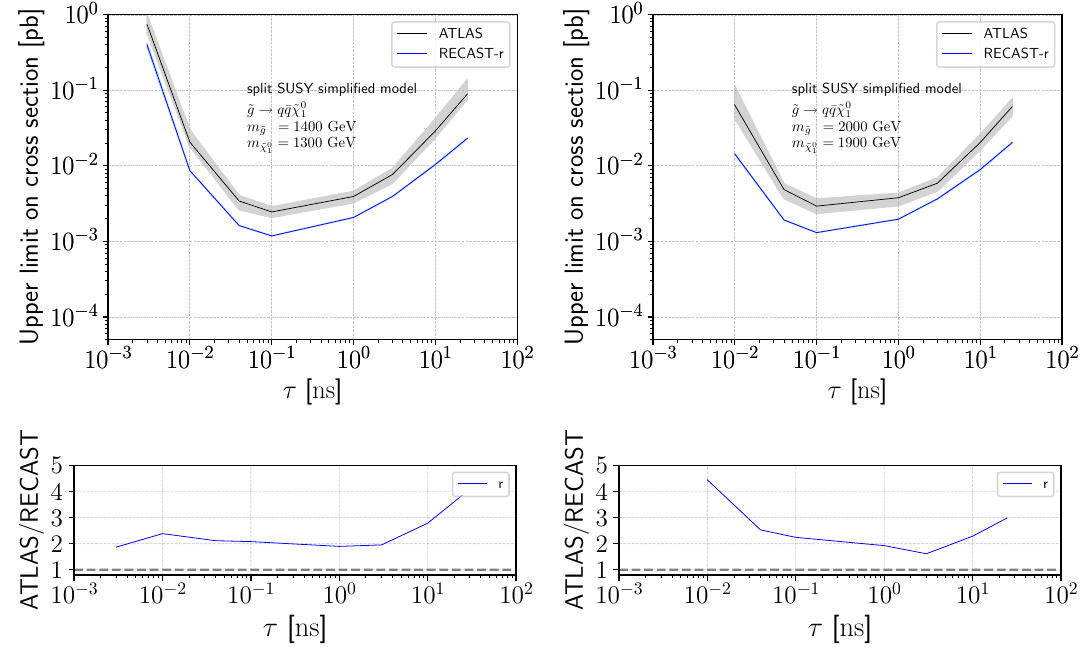
Fig. 7 Scenariowithcompressedspectrum–validationplots.SameconventionsasinFig.2.Weonlypresenttheresultsobtainedwiththesimplified CheckMATE criterion Table 7 Impact of matched m ˜ g = 1 . 4 TeV m ˜ g = 2 TeV events on the DV search for a gluino lifetime of 1 ns. Matched events allow for up to two radiated jets. σ rec represents the lim upper bound on the cross-section in fb, obtained from the recast procedure